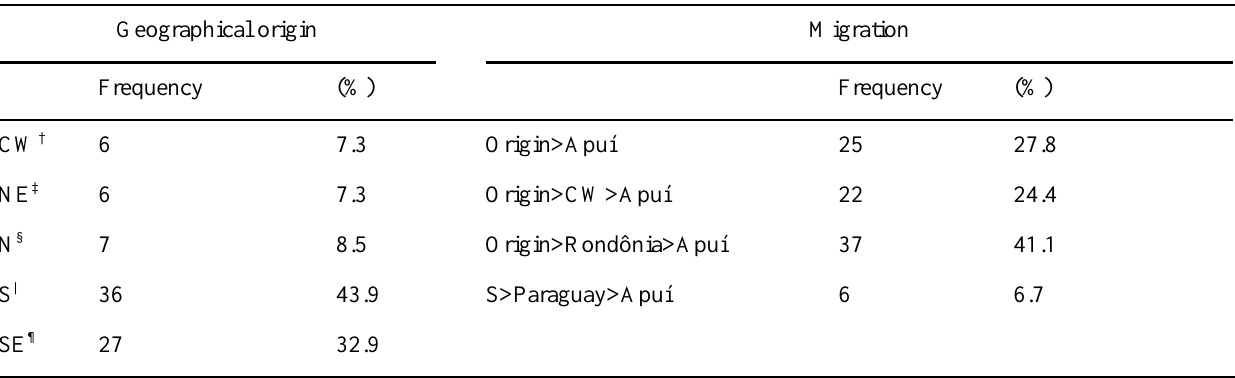
Table 2. Characteristics of the household structure of the sample ( n = 83) and their properties (a); origin and migration (b). Geographical origin Migration